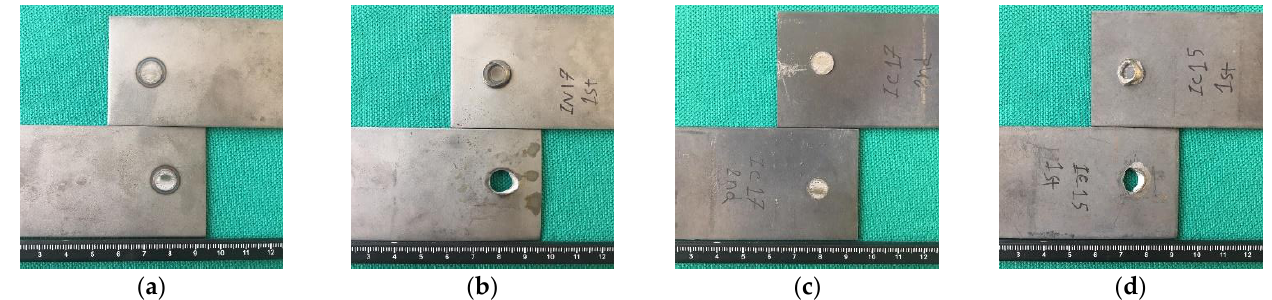
Figure 12. Dynamic failure energy absorption with nugget diameter for both types of material.